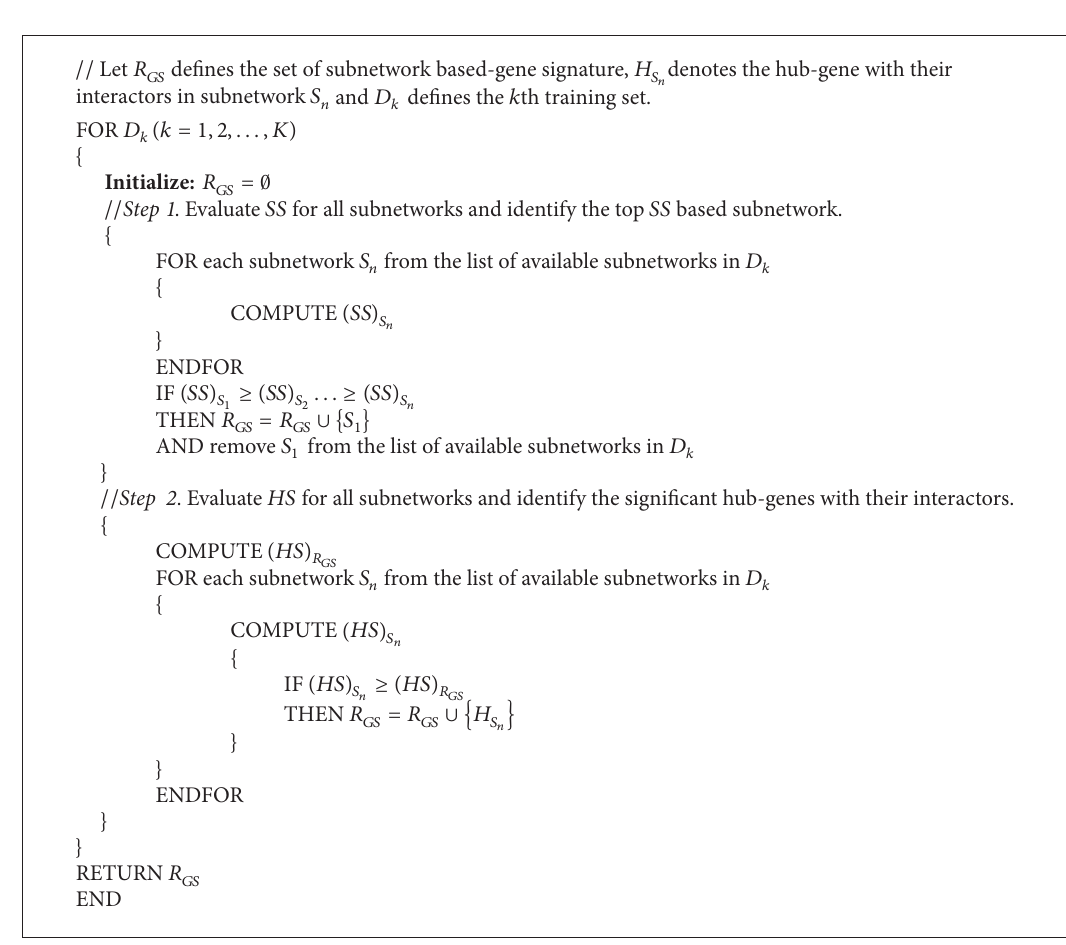
Algorithm 1: Pseudocode for the RRHGE